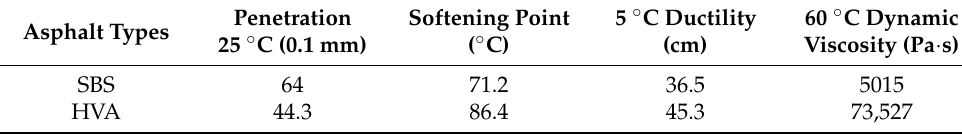
Table 1. Basic properties of two asphalt samples.